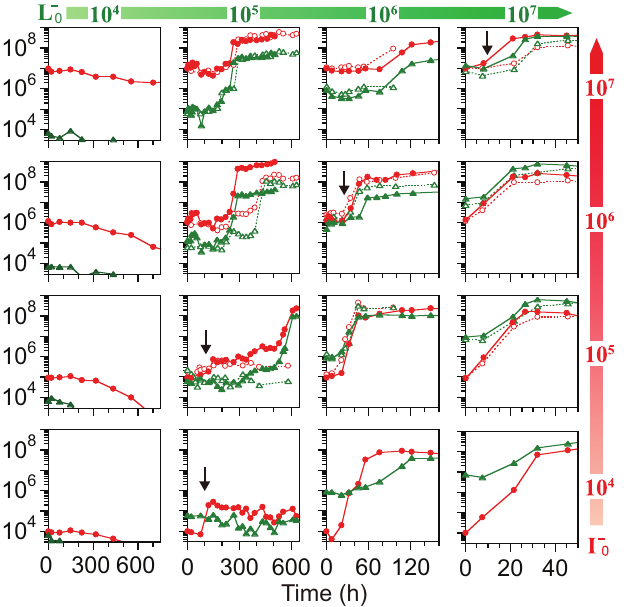
Figure 2. Coculture growth at various initial concentrations of I – and L – cells (I – 0 and L – 0 , respectively). I – and L – concentrations are shown as red circles and green triangles, respectively. Two representative sets of data are shown as closed and open symbols, except when either I – 0 or L – 0 was 10 4 /ml, then only one set of data was obtained. When I – 0 and L – 0 were both at a concentration of 10 5 /ml, mutualism had been established six out of nine times. The features of the mutualism, discussed in the text, were reproducible, although the time scale varied about two-fold. The initial increase in the concentration of I – cells to approximately 10-fold greater than that of L – cells after the lag phase is depicted by arrows.